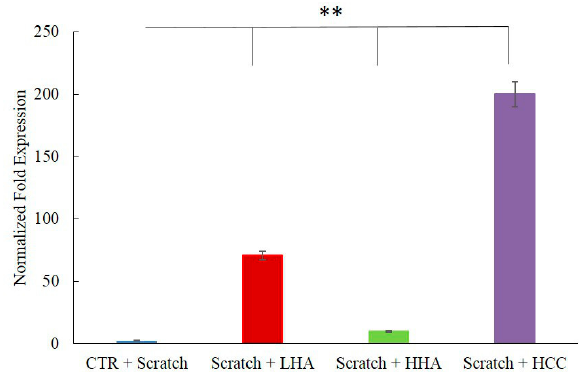
Figure 4. E ff ects of LHA, HHA, and HCC on HBD-2 expression in HaCaT / HDF co-cultures in Figure 4. Effects of LHA, HHA, and HCC on HBD-2 expression in HaCaT/HDF co-cultures in comparison with a control sample. HaCaT/HDF cells were scratched and treated with HA and its comparison with a control sample. HaCaT / HDF cells were scratched and treated with HA and its complex. At 24 h, the total RNA was extracted and qRT-PCR was performed to determine the gene expression of HBD-2. ** p < 0.01 for HCC, HHA, and LHA vs. CTR.